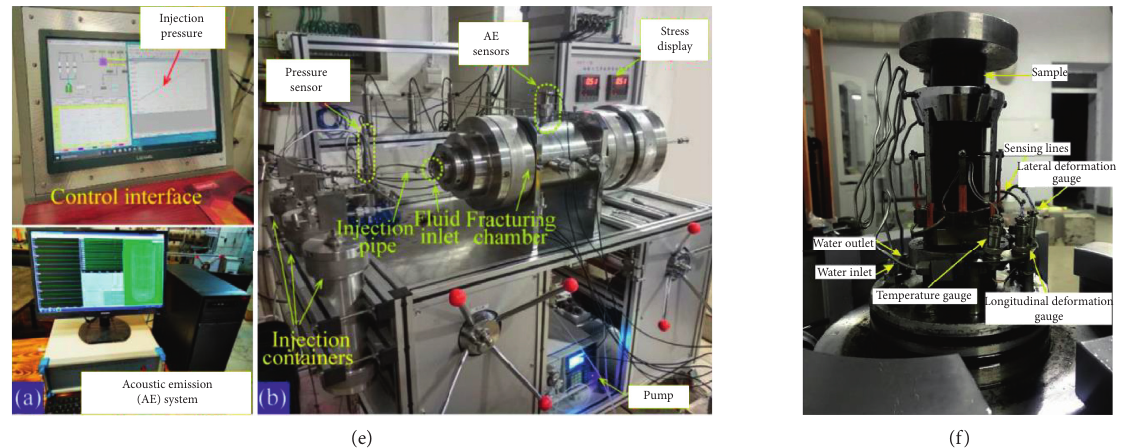
Figure 3: Biaxial type setups for hydraulic fracturing experiments in (a) Wang et al. [64]; (b) Li et al. [29]; (c) Kumari et al. [44]; (d) Zhuang et al. [61]; (e) Chen et al. [65]; and (f) Zhang et al. [59].